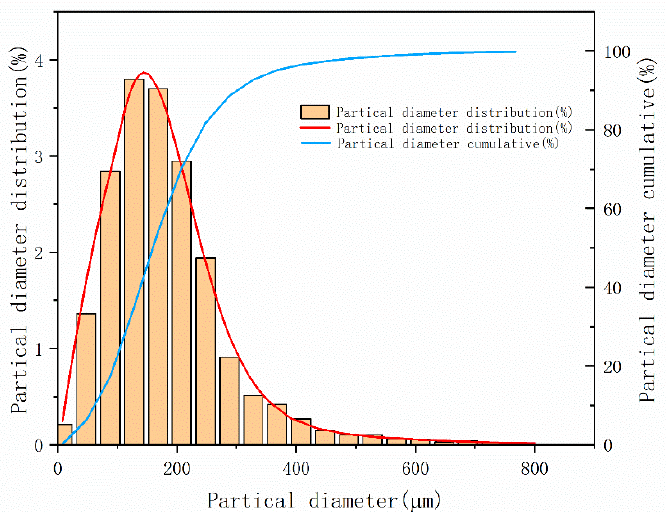
Figure 1. Original powder.